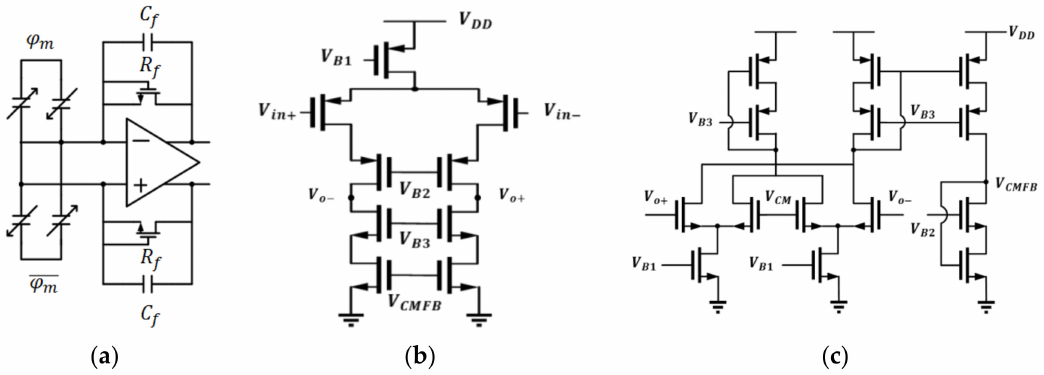
Figure 8. The schematic of the ( a ) capacitance-to-voltage (C/V) stage; ( b ) telescopic operational amplifier; ( c ) the schematic of continuous-time common-mode feedback (CMFB)